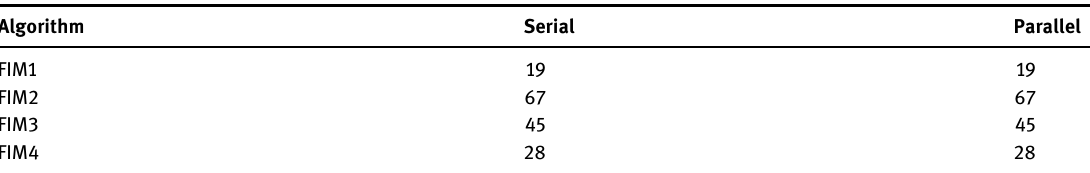
Table 3: Data mining results of serial and parallel for 250 M fi les